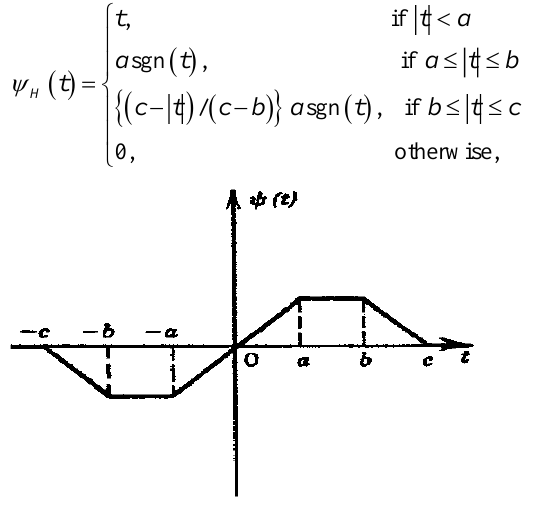
Fig. 1. Hampel-type  -function